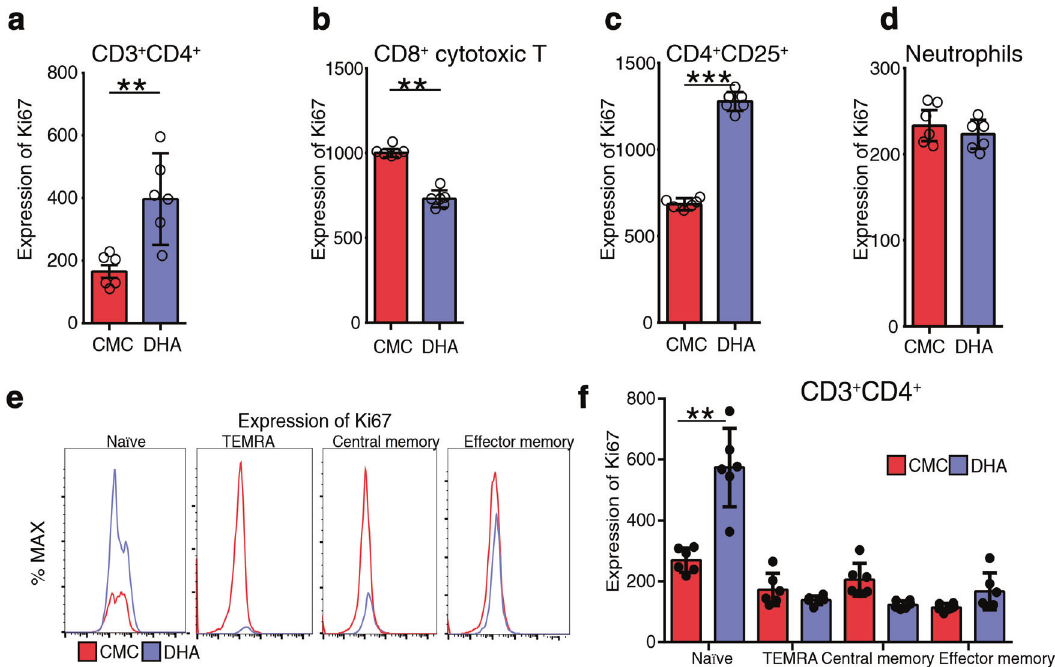
Fig. 3 Assessment of Ki67 expression with fl ow cytometry. a – d Numbers indicate MFI of Ki67 expression at different subgroup in different groups. The expression of ki67 on the different subsets was calculated as MFI = positive staining (MFI)-isotype control (MFI). e Representative histograms showing differential expression of ki67 between DHA and CMC group in different CD3 + CD4 + T cell subsets. f Representative histograms showing differential expression of ki67 between DHA and CMC group in different CD3 + CD4 + T cell subsets ( n = 6). Plot shows the increased expression of ki67 in the naïve CD4 + T cells ( n = 6). A subset of effector memory T cells re-expresses CD45RA (termed TEMRA). DHA = dihydroartemisinin group, CMC = CMC (carboxymethyl cellulose) solvent solution control group; MFI = mean fl uorescence intensities. * p < 0.05; ** p < 0.01; *** p <